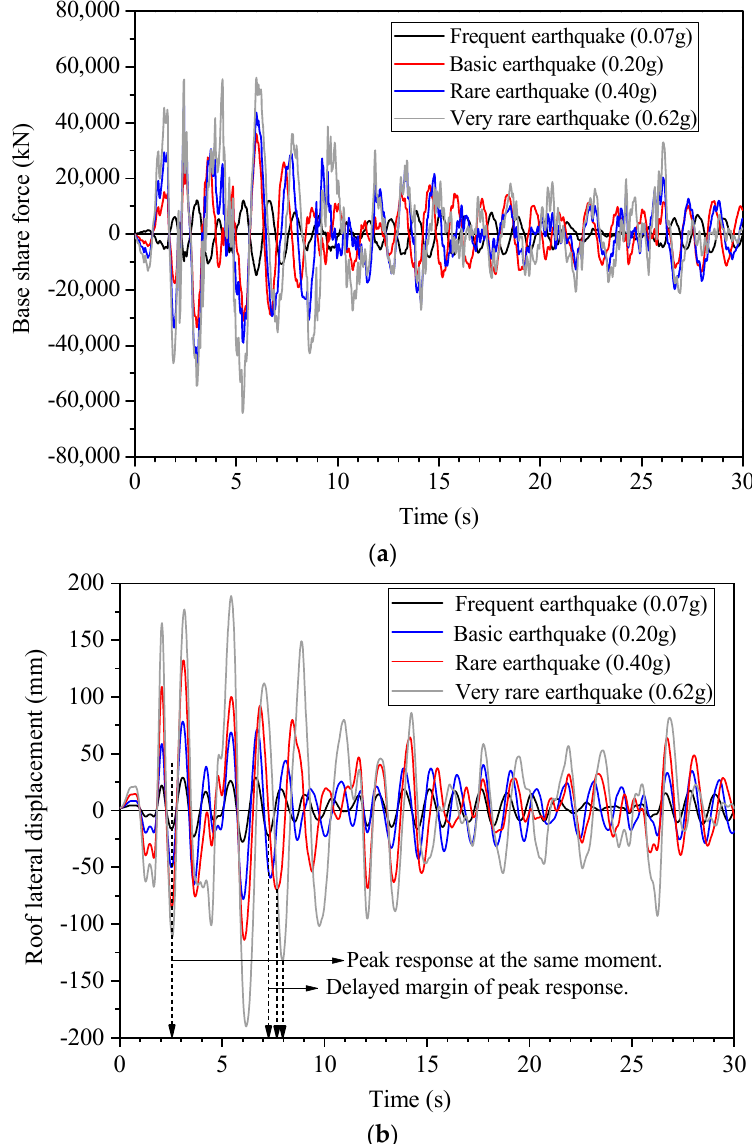
Figure 8. Time-history curves of base shear force and roof lateral displacement under different hazard levels: ( a ) Base shear force; ( b ) roof lateral displacement.